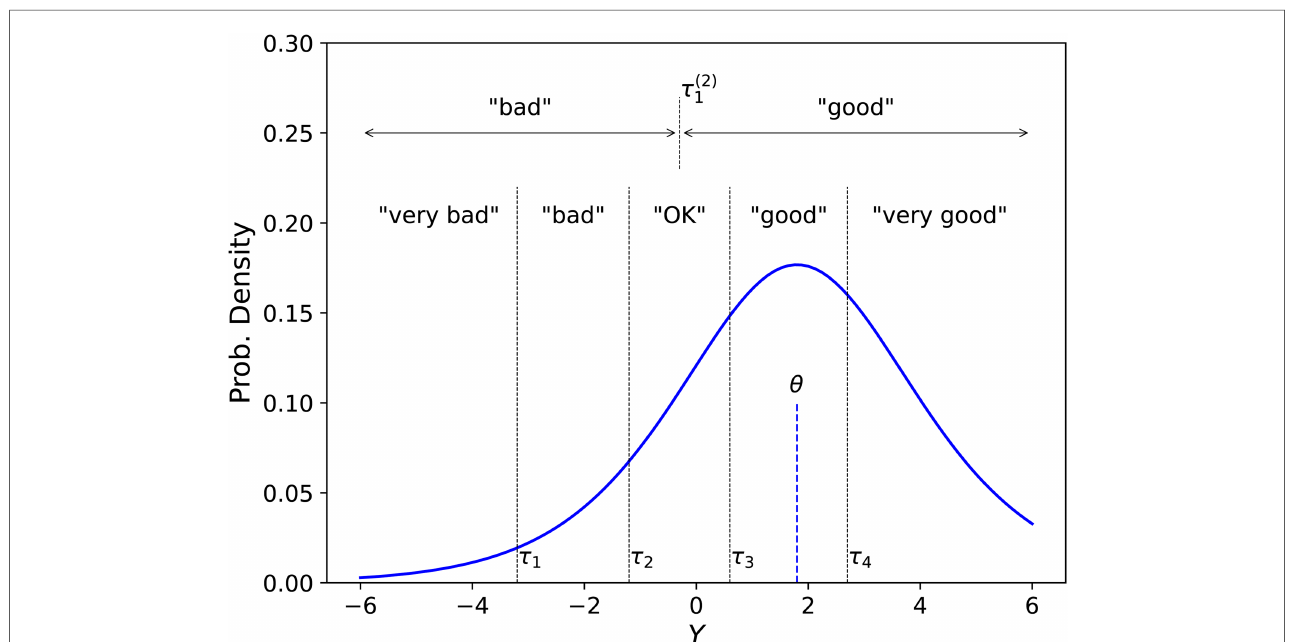
FIGURE 1 Example of a conditional probability density function of the latent random variable Y whose outcomes determine responses to a question about a perceptual attribute, e.g., Speech Understanding, given a true location parameter u ¼ 1 : 8 on the logit scale. Response intervals are exempli fi ed for one study allowing fi ve ordinal response categories, “ very bad, ” “ bad, ” … , “ very good, ” with response thresholds ( t 1 , t 2 , t 3 , t 4 ) ¼ ( (cid:4) 3 : 2 , (cid:4) 1 : 2 , 0 : 6 , 2 : 7), and for a second study evaluating the same attribute with only two allowed responses, “ bad ” or “ good, ” with a single response threshold t (2) 1 ¼ (cid:4) 0 : 3. The present model allows separate location parameters u for each participant, attribute, and situation. The model allows different response thresholds for each participant and attribute, but the thresholds are identical across situations.